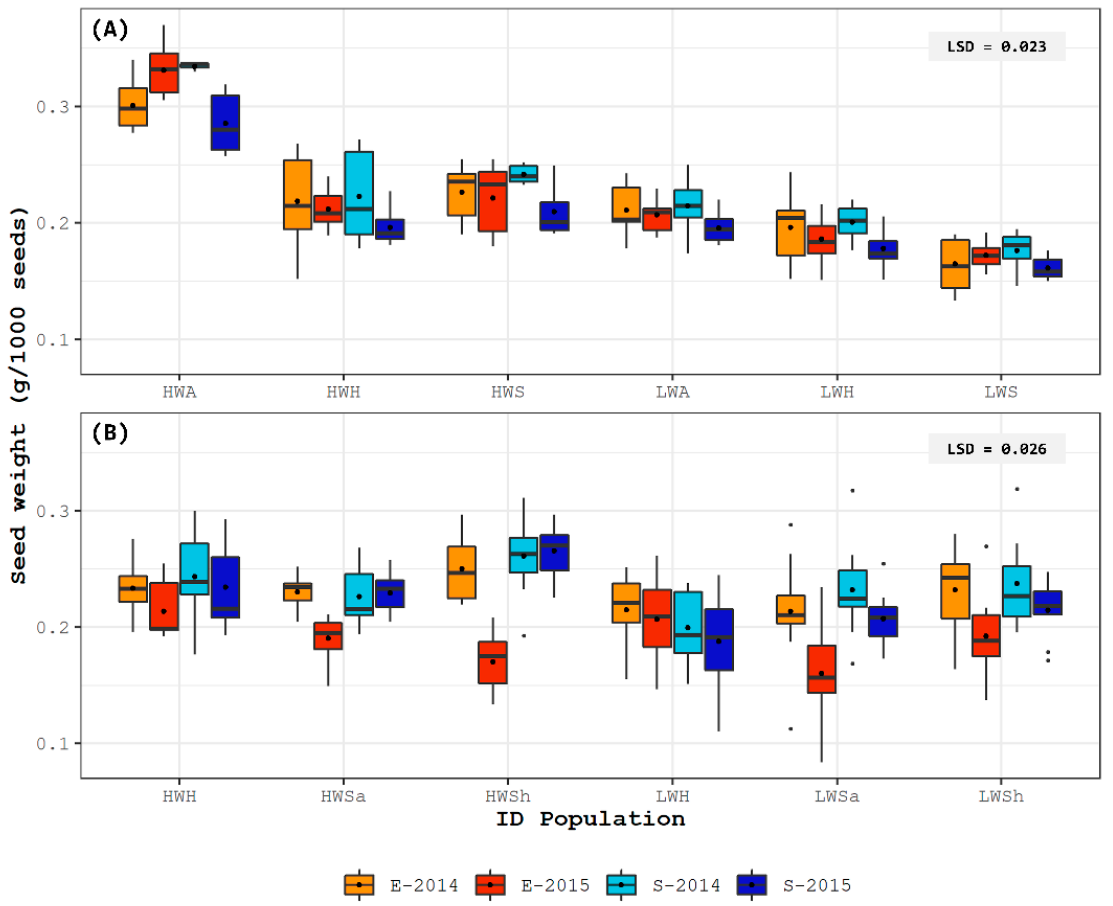
Figure 1. Box-plot for seed weight variation in six populations of ( A ) Leptochloa crinita and ( B ) L. pluriflora, grown in four different environments: Esperanza site, year 2014 (E-2014) and year 2015 (E-2015); Sumalao site, year 2014 (S-2014) and 2015 (S-2015). “ID populations” is composed of seed weight (high/low) and origin of population. HWA: high weight-arid origin. HWH: high weight-humid origin. HWS: high weight-saline origin. HWSa: high weight-semiarid origin. HWSh: high weight-subhumid origin. LWA: low weight-arid origin. LWH: low weight-humid origin. LWS: low weight-saline origin. LWSa: low weight-semiarid origin. LWSh: low weight-subhumid origin. LSD: Least Significant Differences according Tukey test ( p < 0.05).